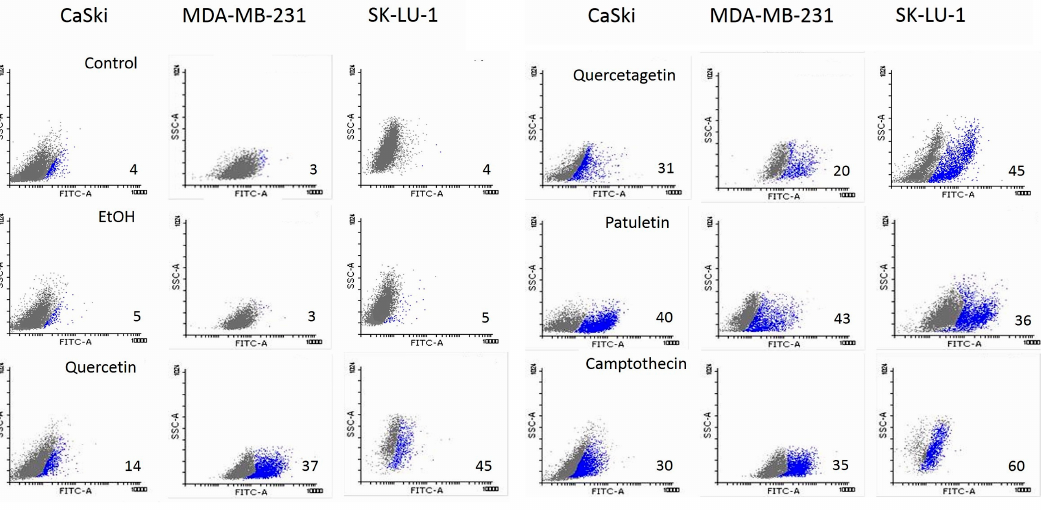
Figure 10. Detection of active caspase-3 in CaSki, MDA-MB-231 and SK-Lu-1 cell cultures exposed to quercetin, quercetagetin and patuletin at the aforementioned IC 50 values. Cells were analyzed by FACS from Cell Quest; numbers indicate the percentages of caspase-3 activity.